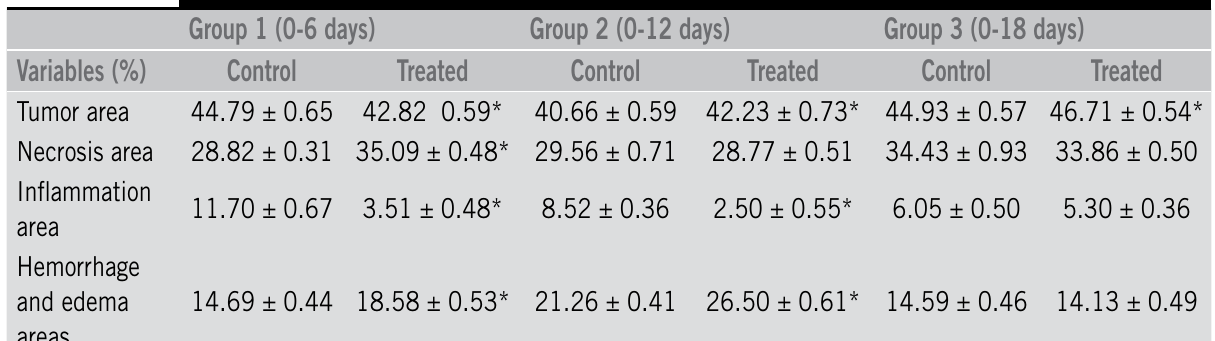
Means and standard deviation of the morphometric variables of solid Ehrlich tumor features in Table control and treated